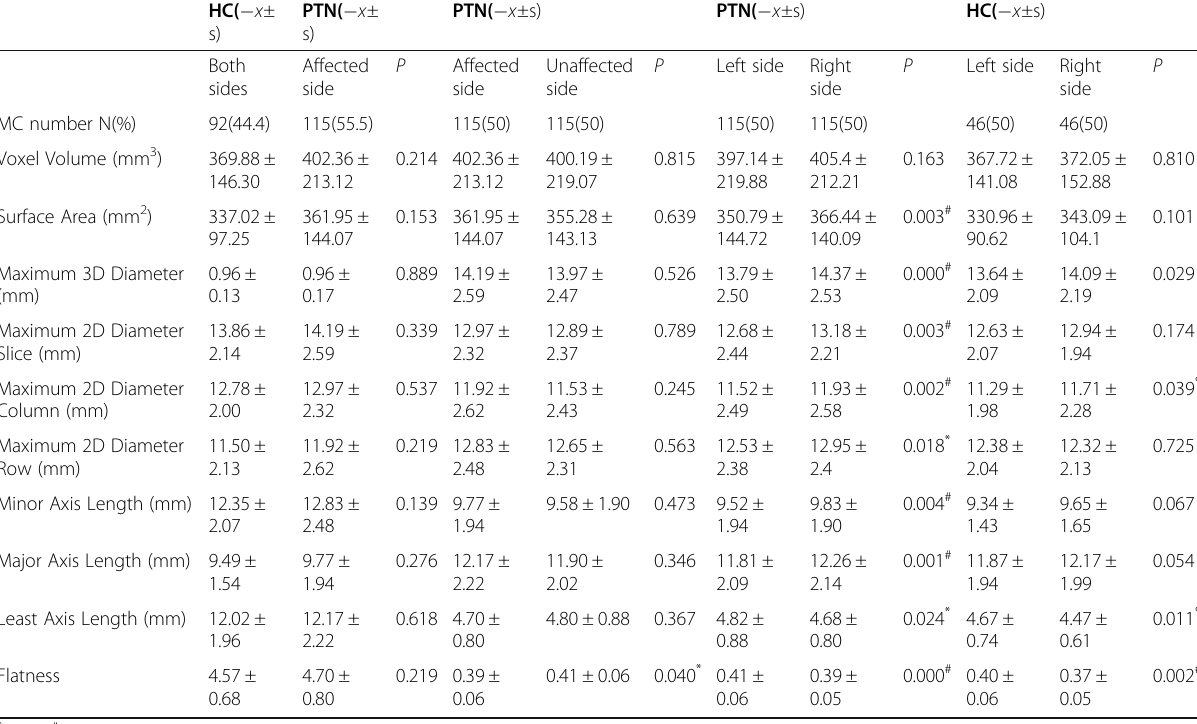
Table 2 Morphological analysis of